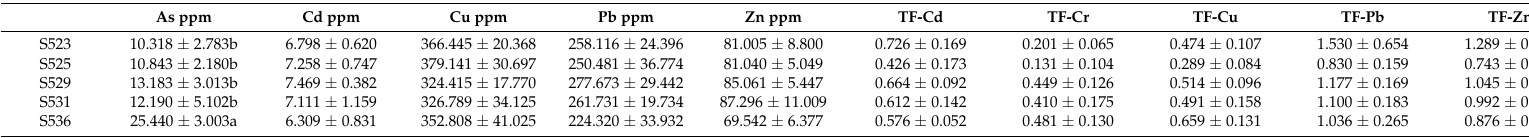
Table 2. Soil heavy metals of the different sub-dams and transfer factors of different heavy metals in B. ischaemum (Mean ± Standard error). The different case letters (a > b > c) indicate that the means are significantly different among reclaimed scenario ( p < 0.05) with the Duncan test.